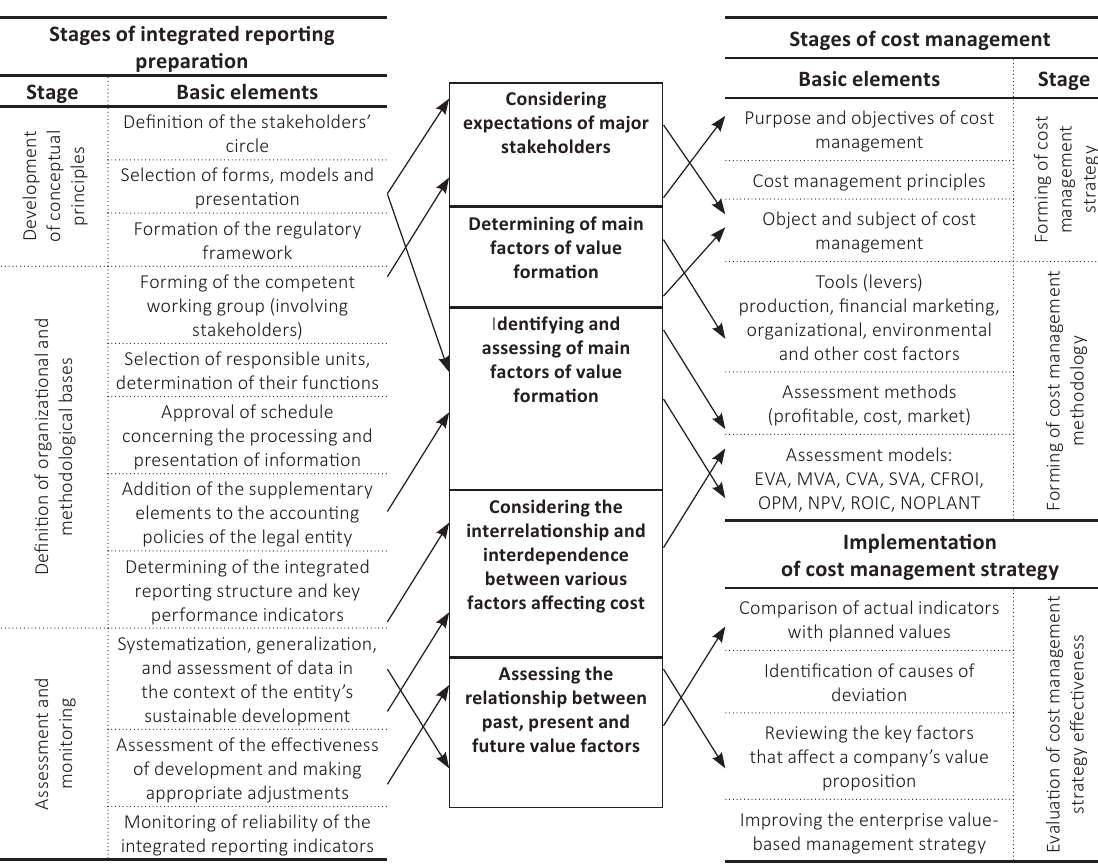
Figure 1. Incorporation of integrated reporting into the enterprise VBM